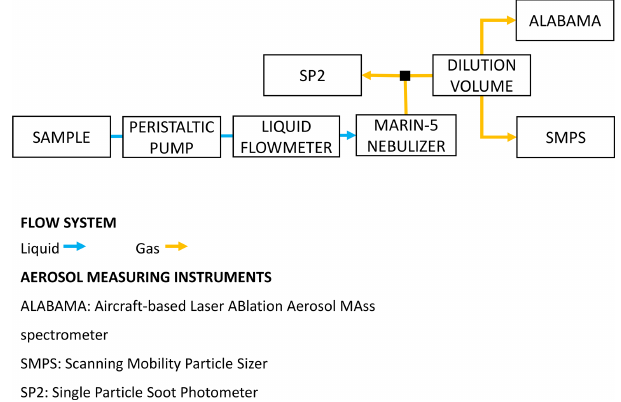
Figure 1. Schematic of the instrumental setup deployed to analyze the PASCAL snow samples and to perform the laboratory test ex- periments. ALABAMA (aircraft-based laser ablation aerosol mass spectrometer) was not available for laboratory test